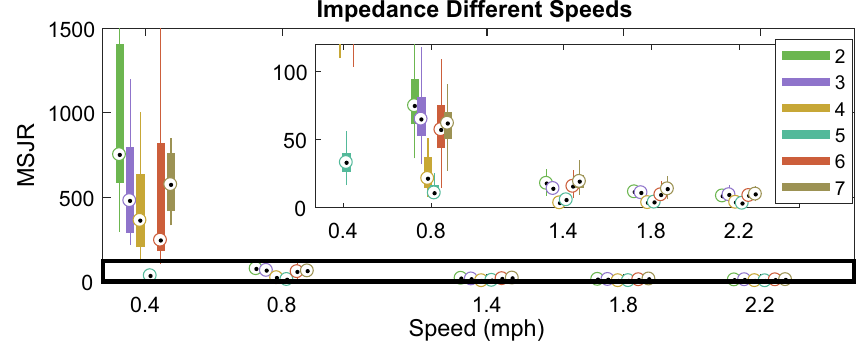
(c) Level walking with imposed ankle impedance (stiffness=100Nm/rad, controller damping=0Nms/rad) at five different speeds: 0.4mph(0.65km/h), 0.8mph(1.29km/h), 1.4mph(2.25km/h), 1.8mph(2.90km/h) and 2.2mph(3.54km/h). Inner plot is zoomed to MSJR= ( 0 , 120 ) range. Data from Subject 1 was corrupted by noise in these trials and therefore not used (see Supplementary Table S1). Figure 1. Box-plots of the mean-squared jerk ratio (MSJR) for each